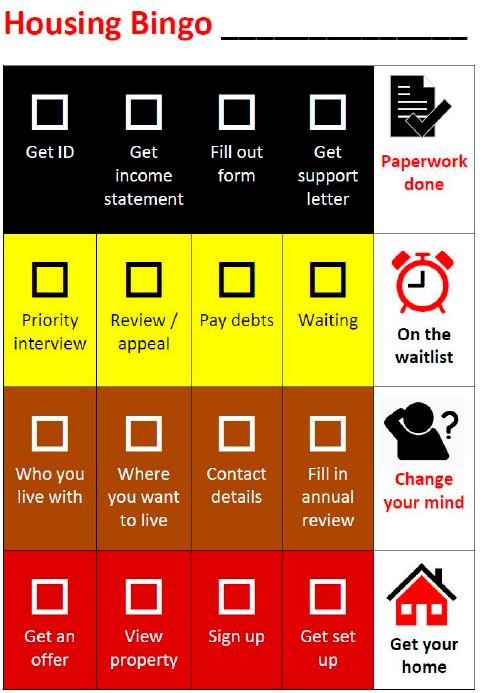
Figure 4. Housing Bingo card. This diagram has been developed by Ruah’s Wongee Mia Action Research Group (L.W., M.P., E.T.).